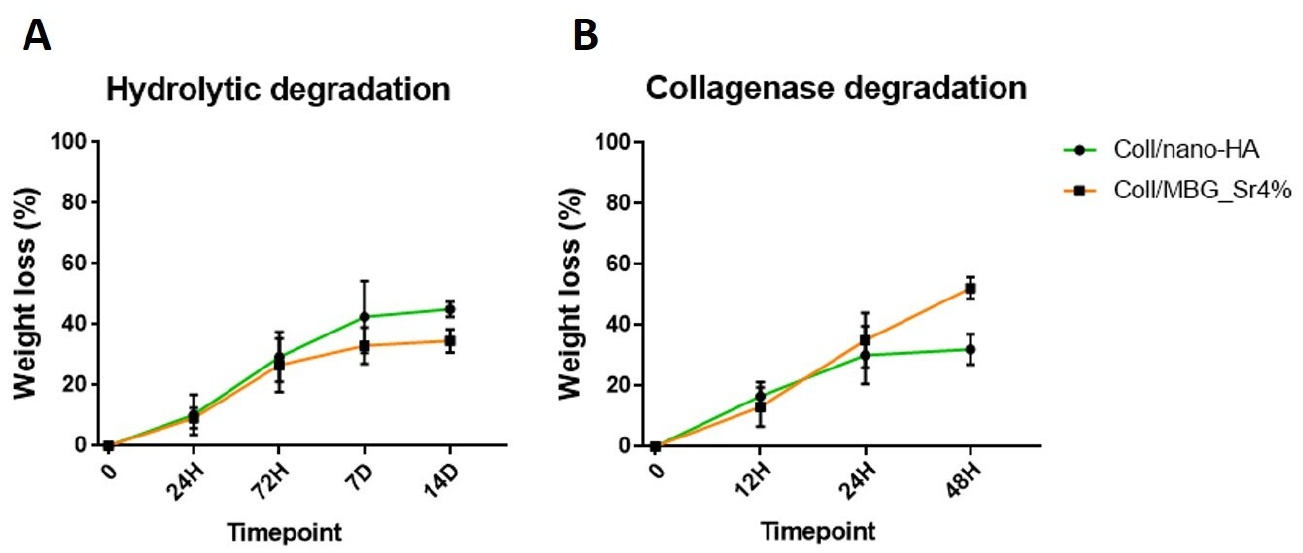
Figure 4. Hydrolytic ( A ) and enzymatic ( B ) degradation of Coll/MBG_Sr4% and Coll/nano-HA systems.